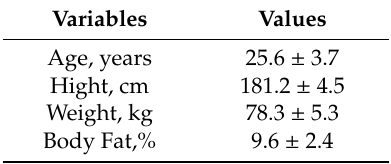
Table 1. The participants’ somatic